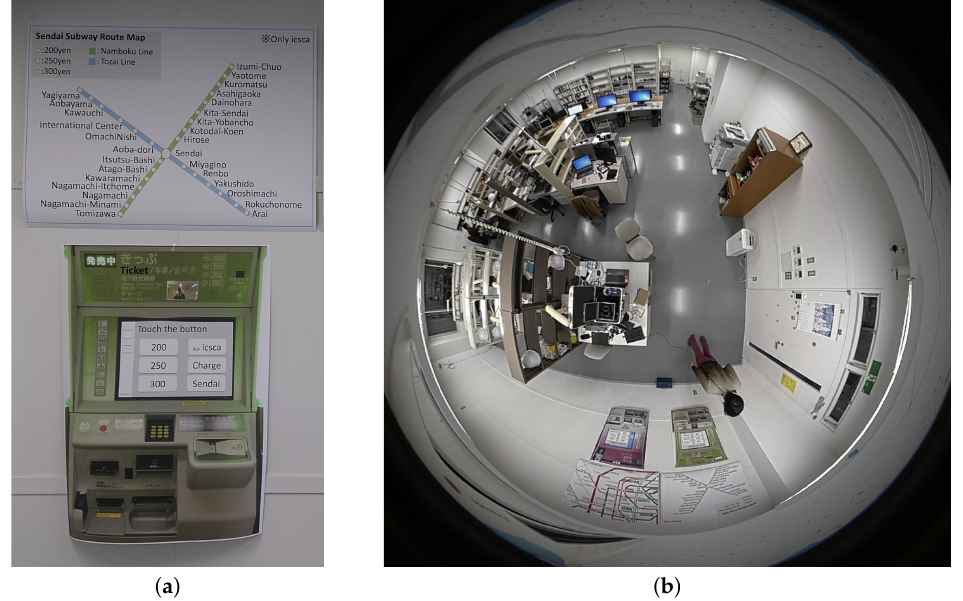
Figure 4. Experimental environment. ( a ) printed image of ticket vending machine and route map affixed to wall; ( b ) omnidirectional image acquired by fisheye camera. Table 3. Portion of text